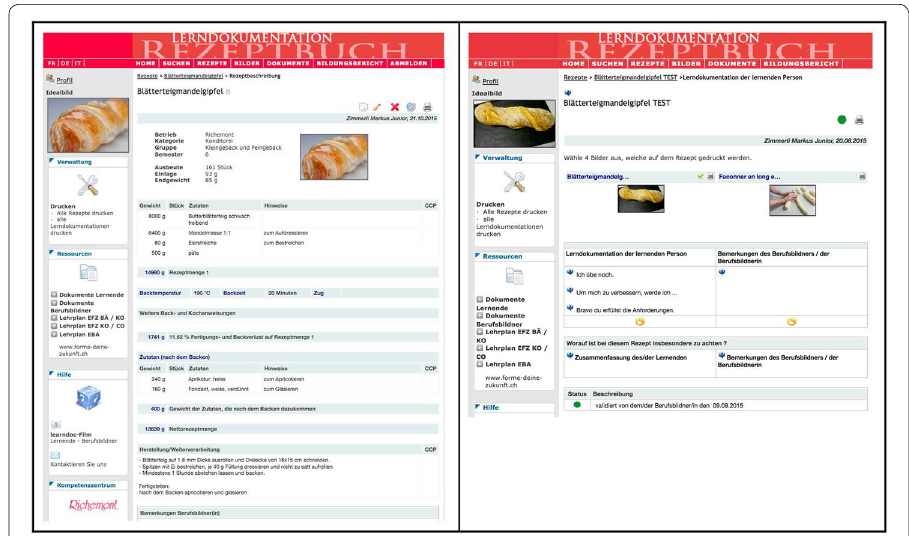
Fig. 1 An example of a recipe (left), including an “ideal picture, and of a learning journal (right) including pictures presenting intermediate states as well as answers to